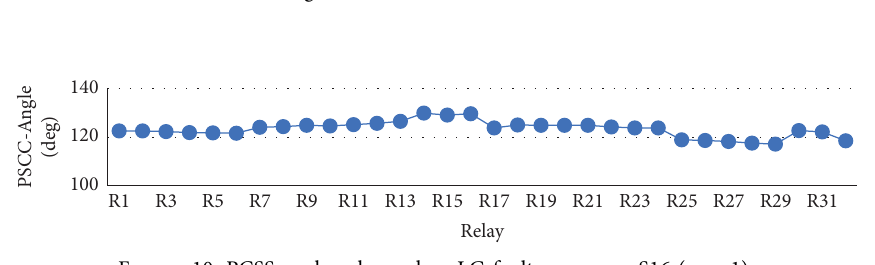
Figure 9: PCSS angle values when LG fault occurs on S3 (case 1).